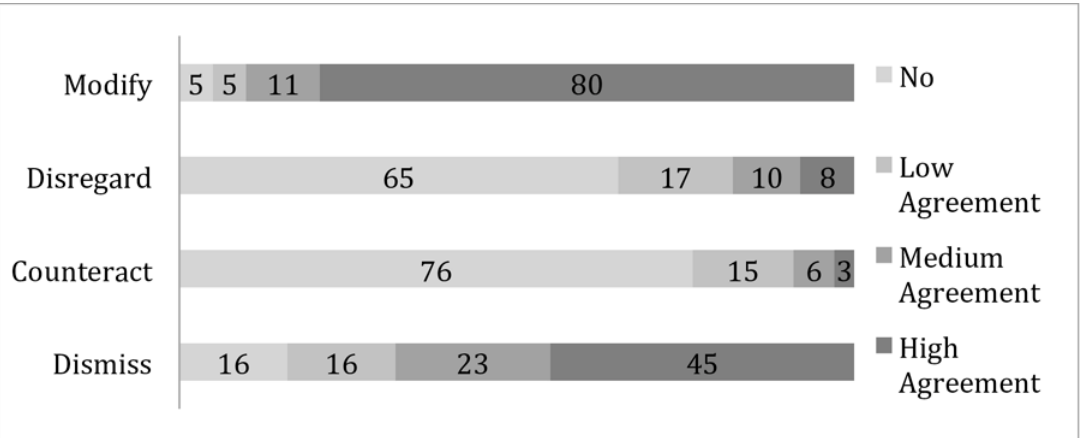
Fig 3. Proportion of participants (n = 88) agreeing with four risk management responses to environmental insecurity, Torotorofotsy, Madagascar, May